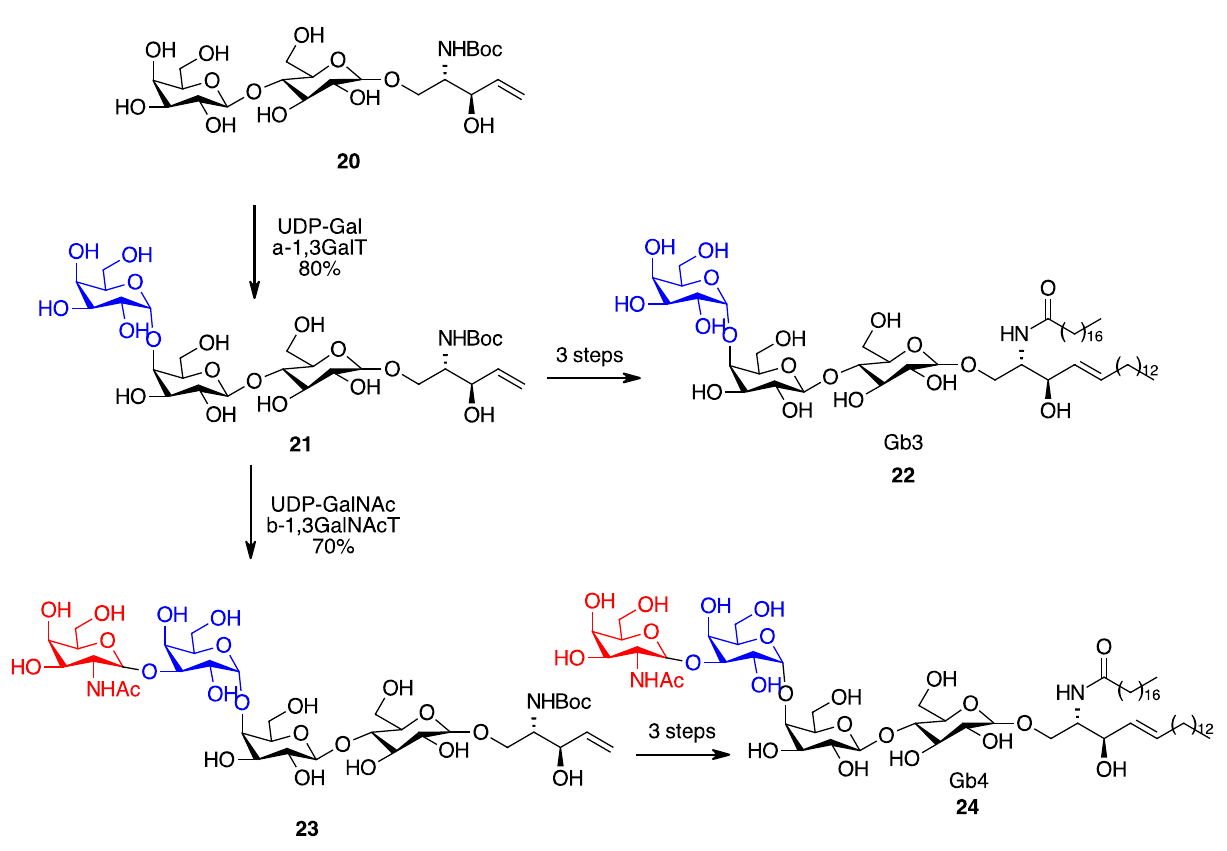
Scheme 8. Variable chemoenzymatic glycosylation strategy for the synthesis of Gb3 ( 23 ) and